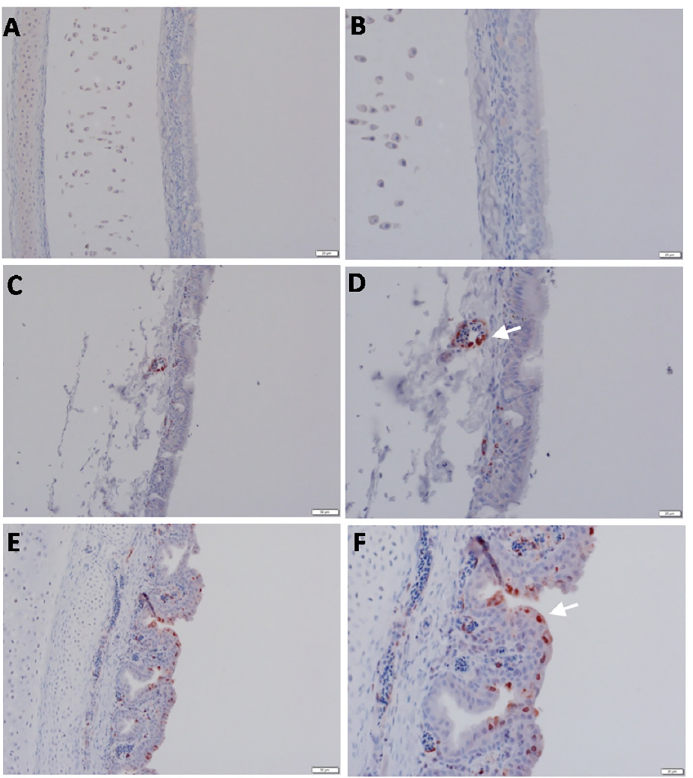
Fig 3. Detection of viral NP antigen in trachea by IHC. ( A and B ) Trachea of non-infected birds (X = 50 and 20 μ m, respectively). ( C and D ) Endothelial cells of trachea of infected birds (X = 50 and 20 μ m, respectively). (E and F) Epithelial cells of trachea of infected birds (X = 50 and 20 μ m,